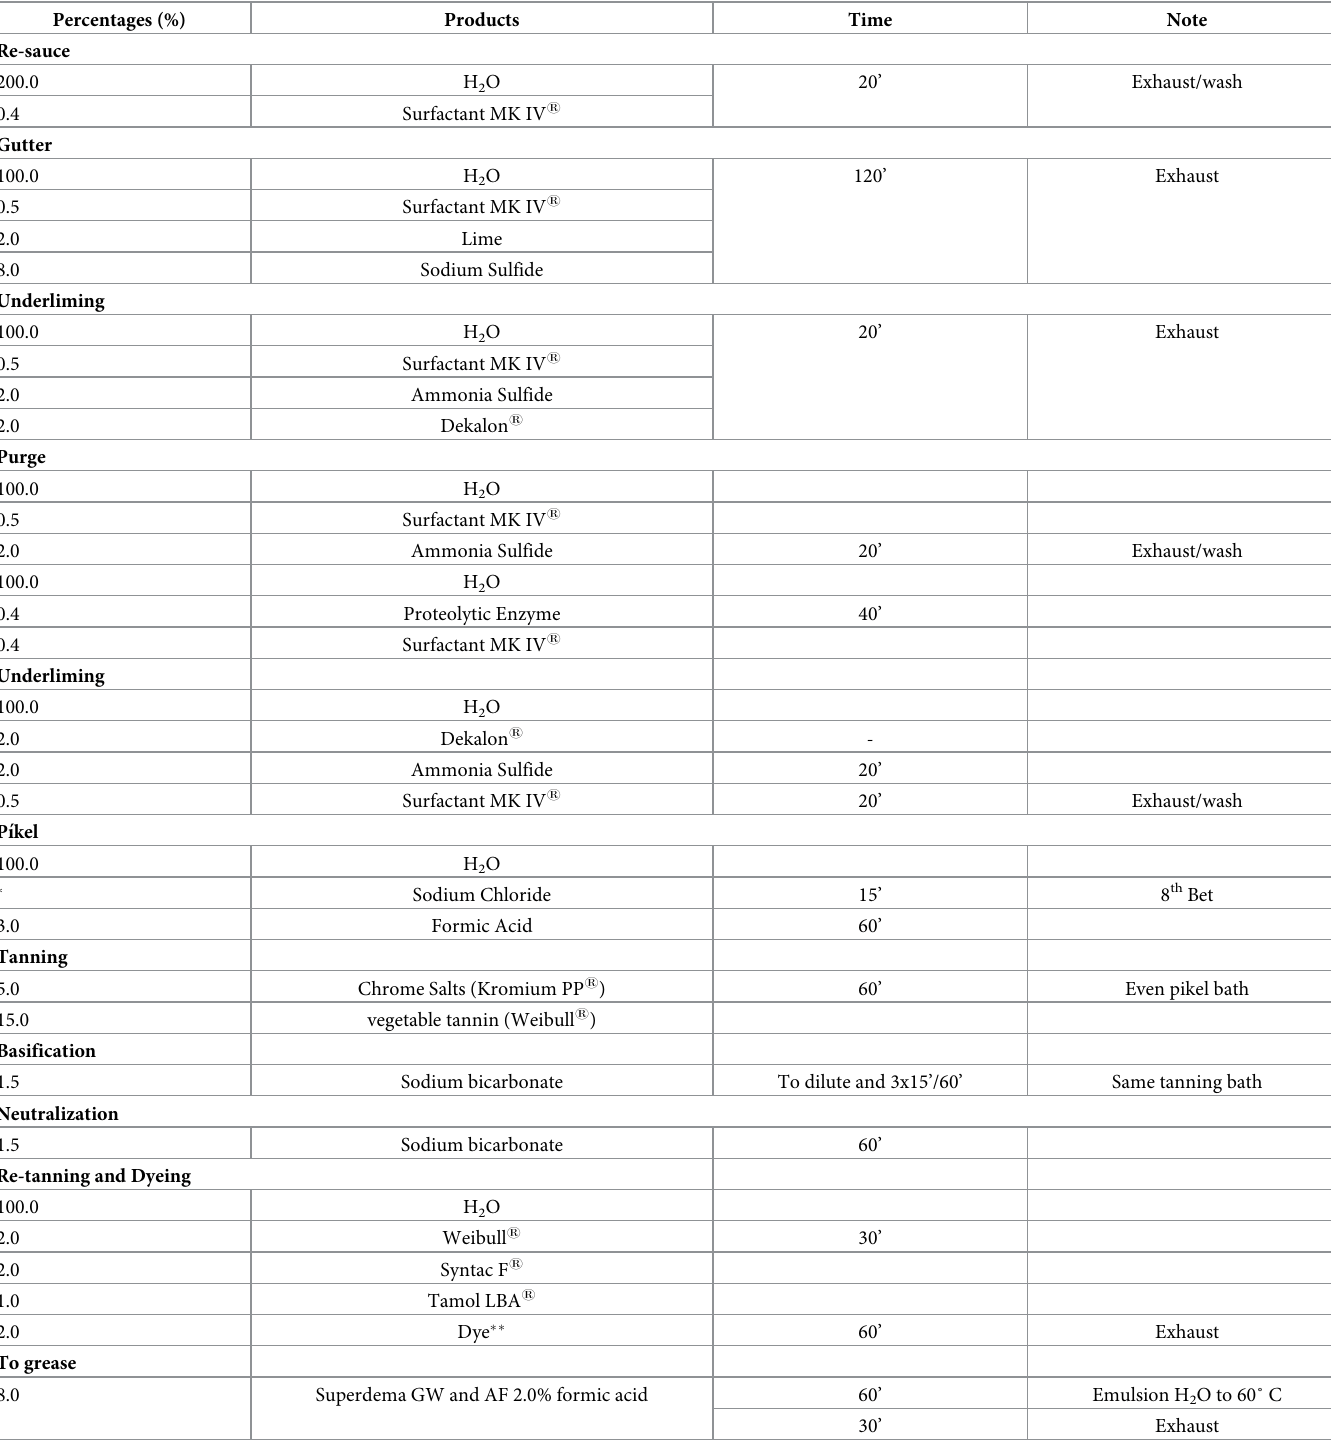
Table 1. Percentages of products, time corresponding to each step, process observations, pH in each step of the Nile tilapia ( O . niloticus ) skin tanning